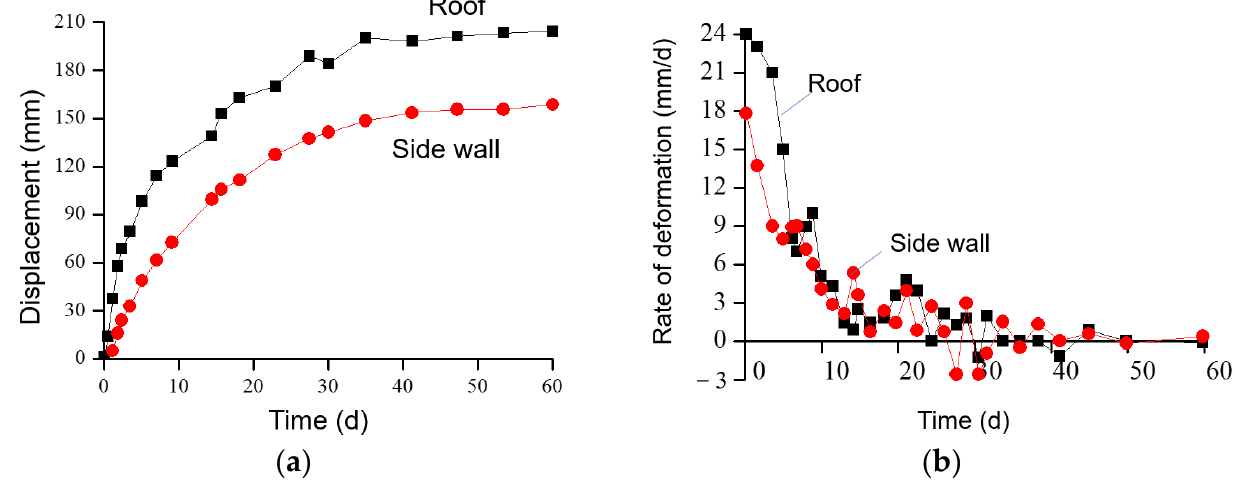
Figure 15. Field monitoring results. ( a ) Roadway deformation monitoring results; ( b ) roadway